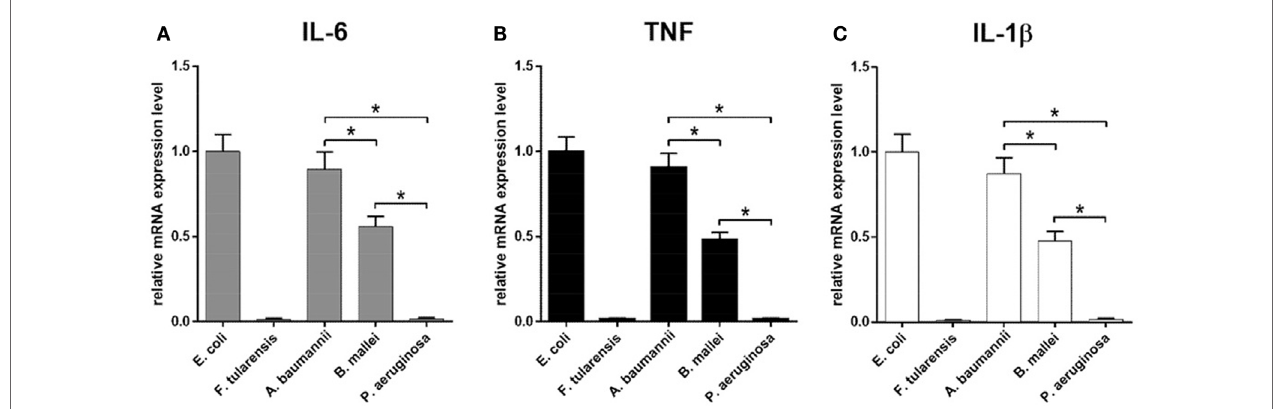
FigUre 4 | induction of mrna of proinflammatory cytokines in BMDM activated by lPs isolated from various bacteria . Quantification of IL-6 (a) , TNF (B) , and IL-1 β (c) mRNA levels in BMDM isolated from WT mice. Relative mRNA expression levels were normalized to β -actin. All data are representative of three or more independent experiments. Data represent mean values ± SEM. * P < 0.05, as calculated by Student’s t test.